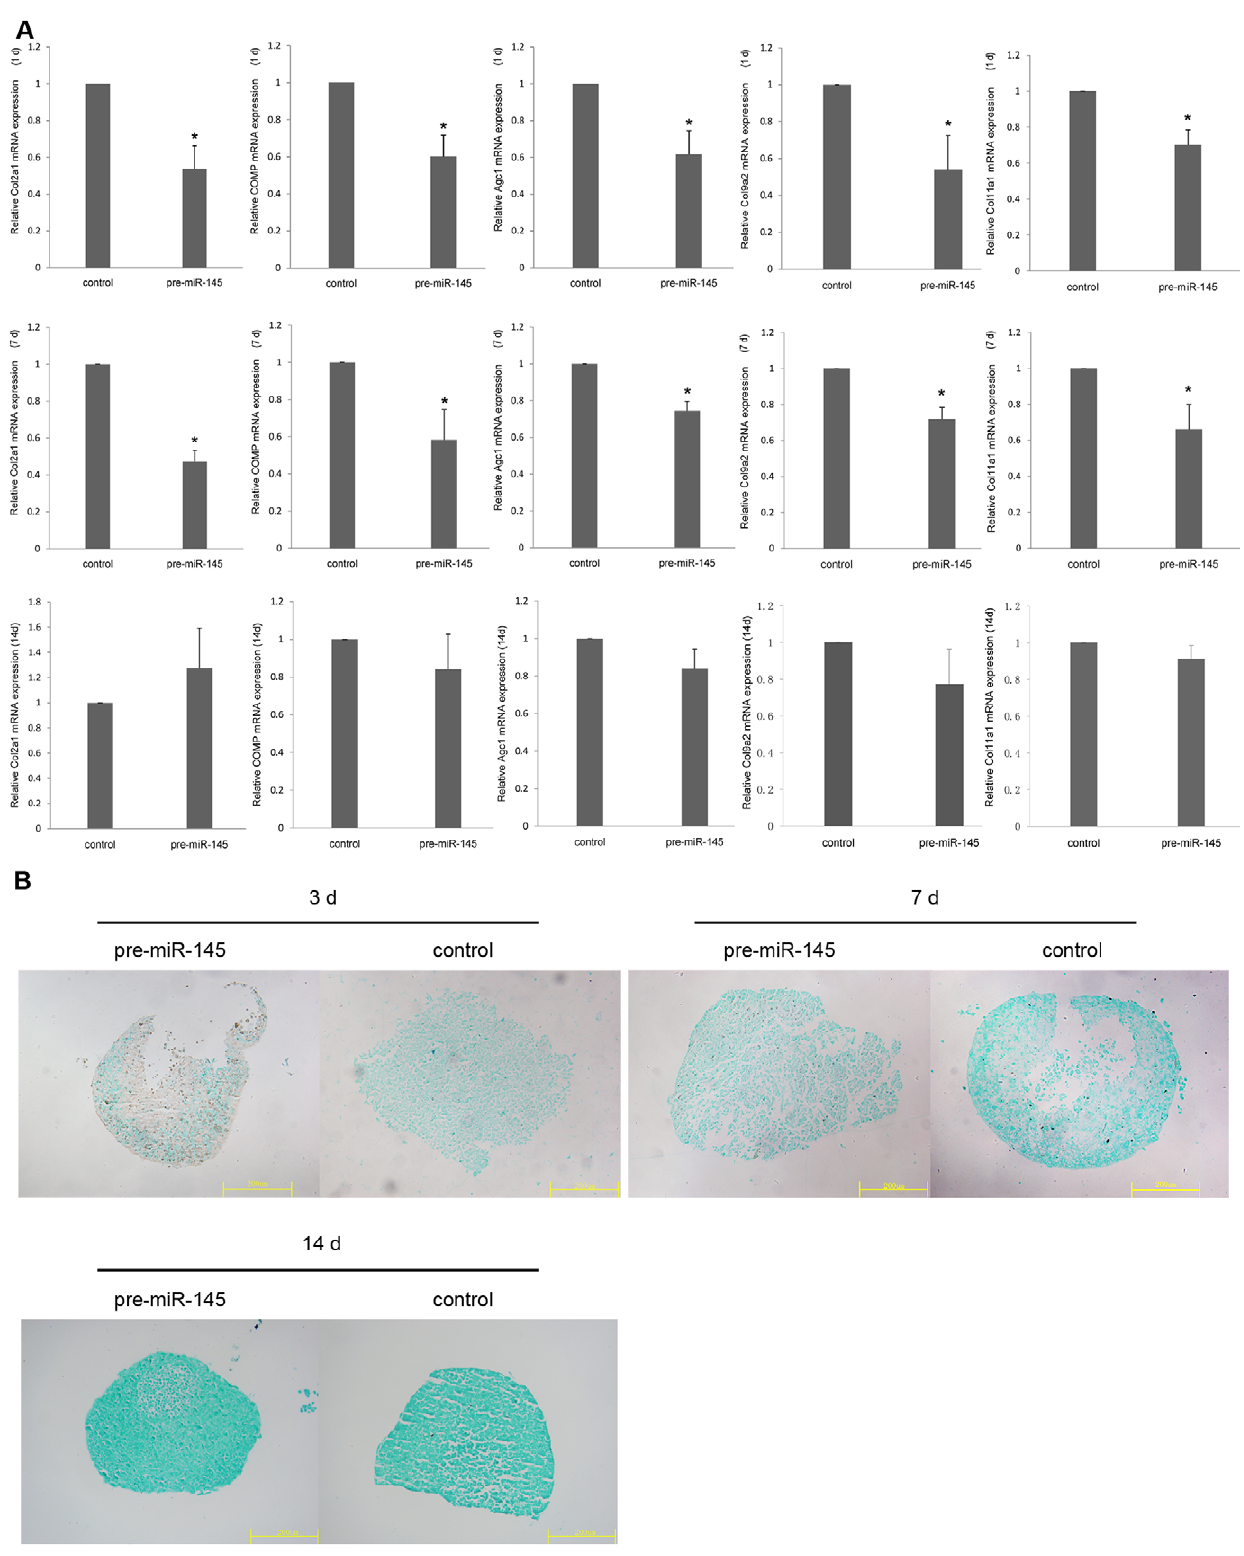
Figure 4. Over-expression of mir-145 inhibits early chondrogenic differentiation of C3H10T1/2 cells. C3H10T1/2 cells were transfected with pre-miR-145 or its control respectively. (A) After 24 h, 7 d and 14 d of treatment with TGF- b 3, all of cells were lysed and then the expression of chondrogenic differentiation markers, such as Col2a1, COMP, Agc1, Col9a2 and Col11a1, were measured via qRT-PCR. The relative expression level of mRNA in cells transfected with control oligonucleotide was set to one, as control. (B) After 3 d, 7 d and 14 d of treatment with TGF- b 3, all of pellets were measured by alcian blue staining. Three independent experiments were done and data was represented as mean 6 sd. *, p , 0.05, when compared with control.